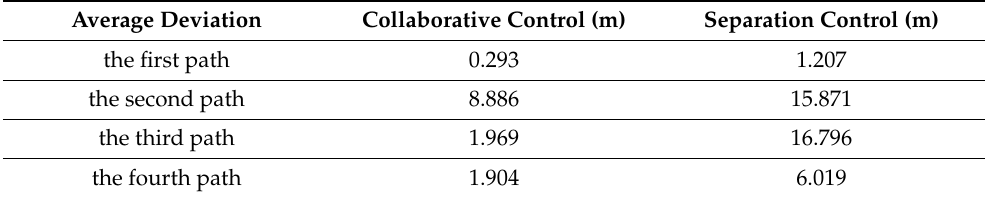
Table 6. Average deviation of the collaborative control and separation control. Average Deviation